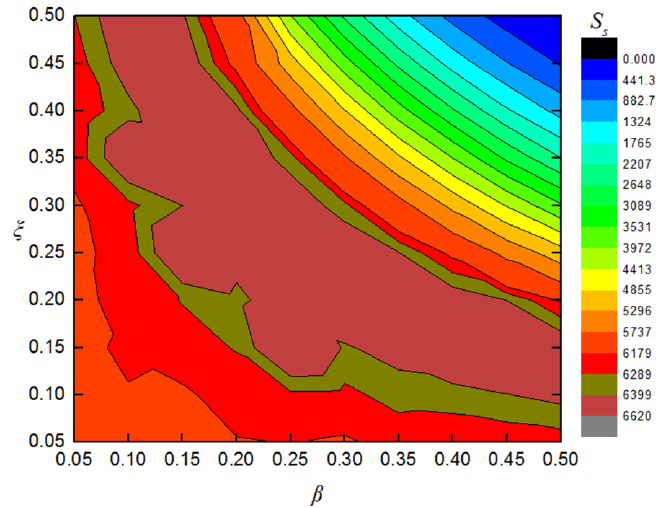
Figure 14. Variation in index S s with β and ξ .